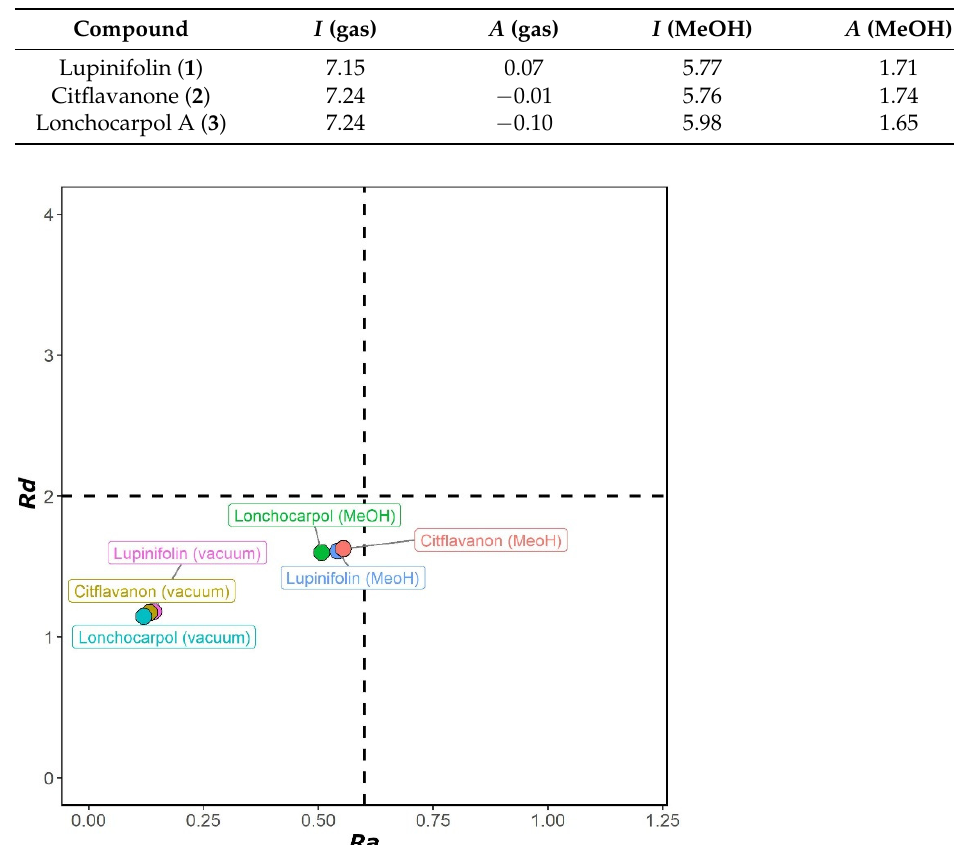
Table 3. The values of I and A for flavanones 1 - 3 in the presence of methanol solvent at the B3LYP/6- 31+G (2d,2p) level of theory (in eV).